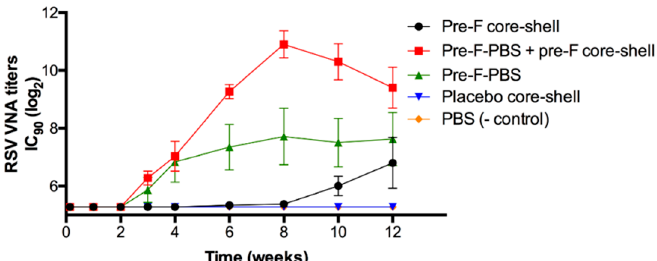
Figure 8. RSV VNA titers over time. Pre-F core-shell = black circle, pre-F-containing core-shell implant at day 0; Pre-F-PBS + pre-F core-shell = red square, s.c. injection pre-F at day 0 and pre-F-containing core-shell implant at day 0; Pre-F-PBS = green triangle, s.c. pre-F injection at day 0; Placebo core-shell = blue triangle, placebo core-shell implant at day 0; PBS (- control) = orange diamond, s.c. injection PBS at day 0 and s.c. injection PBS at week 3. Each group contained 6 mice, except